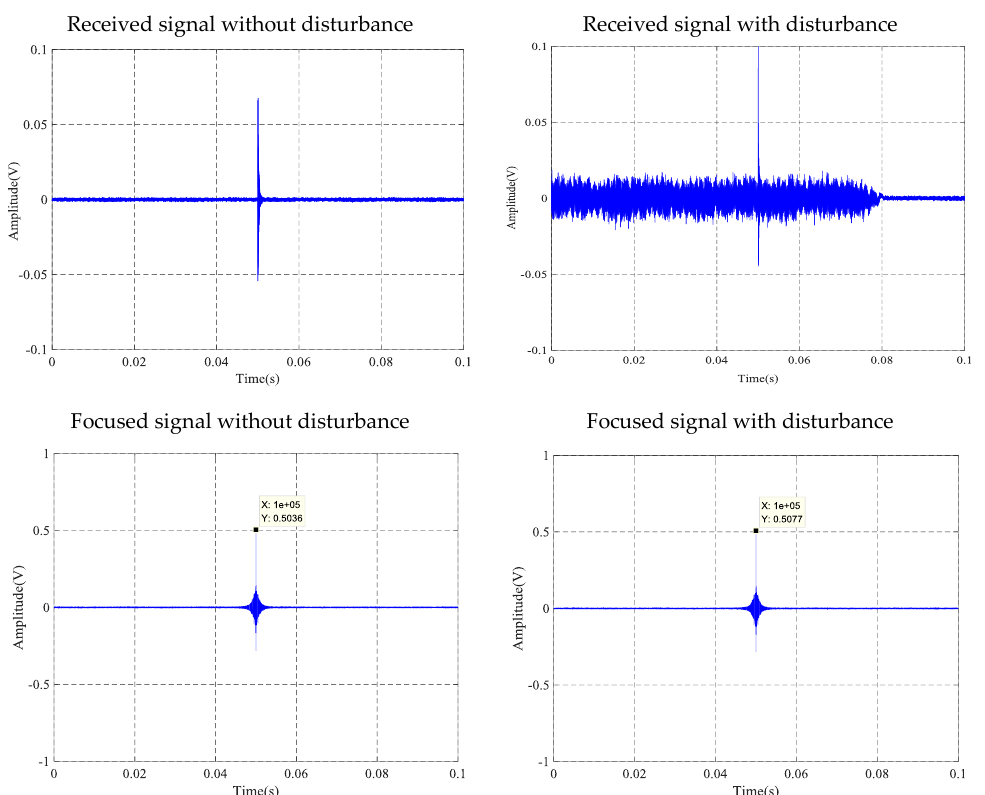
Figure 18. Anti-disturbance ability test at 0.2 MPa tension level of wedges and barrel.